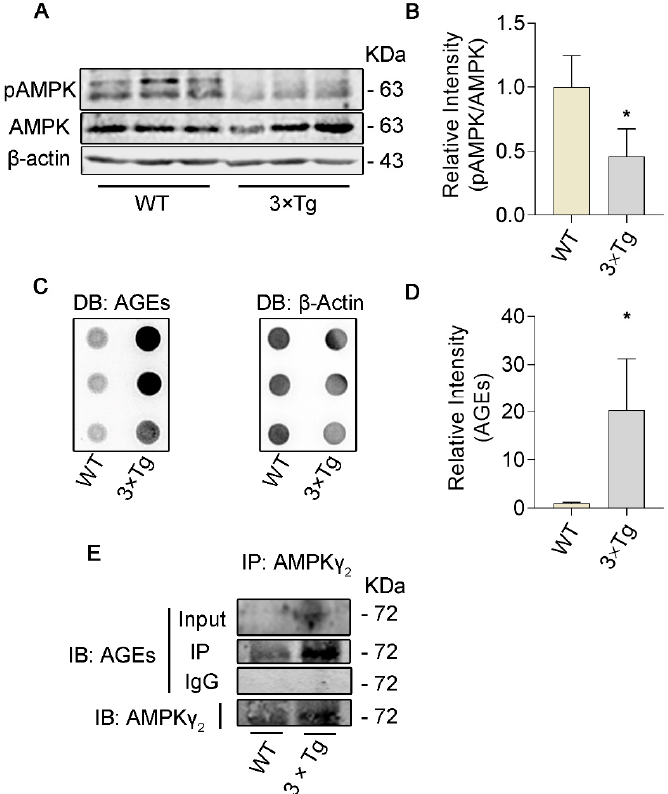
Figure 1. The level of glycation in γ 2 subunit of AMPK is increased and the level of pT172 − AMPK is decreased in 3 × Tg mice. The hippocampal proteins are extracted from 7.5 − month − old 3 × Tg mice and wild − type (WT) mice. ( A , B ) The expression and quantitative analysis of pT172 − AMPK and AMPK were examined by western blot in the hippocampi of 3 × Tg and WT mice. ( C , D ) The level of advanced glycation end − products (AGEs) of brain proteins in 3 × Tg and WT mice were detected by dot blot. ( E ) Hippocampal extracts were immune − precipitated by antibody against AMPK γ 2 and then detected with antibody against AGEs. All data are presented as the means ± SD ( n = 3), statistical analysis with Student’s unpaired t test; * p < 0.05 vs. WT